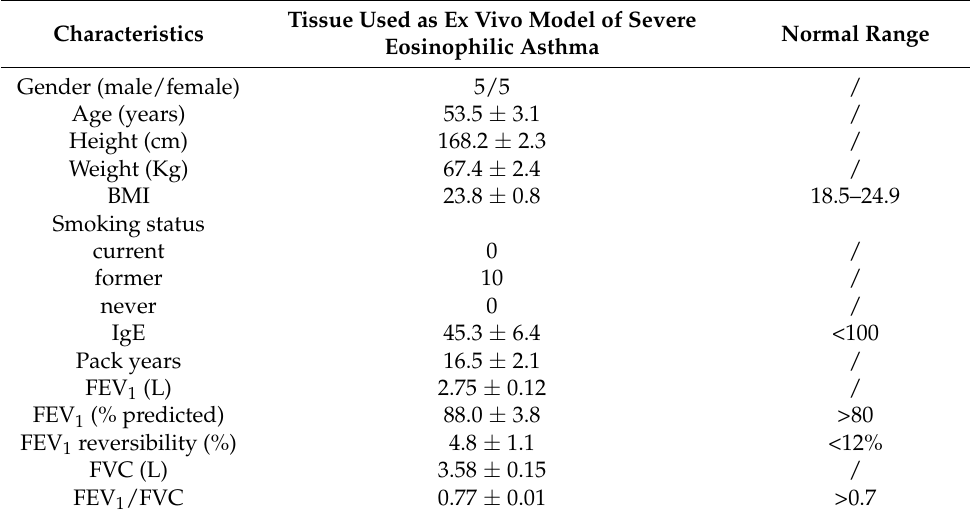
Table 1. Demographic characteristics of human subjects and normal ranges, according to GOLD and GINA recommendations